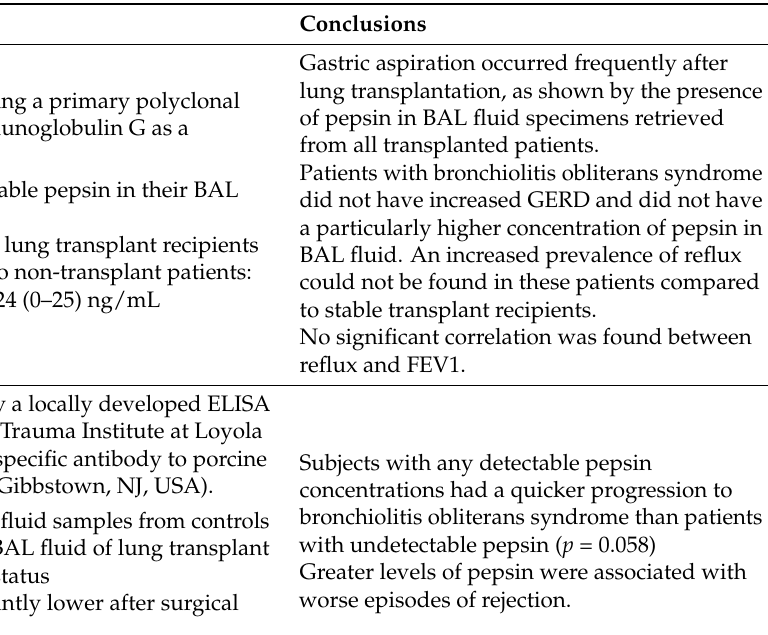
Table 4. Summary of the studies investigating pepsin levels in biological fluids retrieved from adult subjects who underwent lung